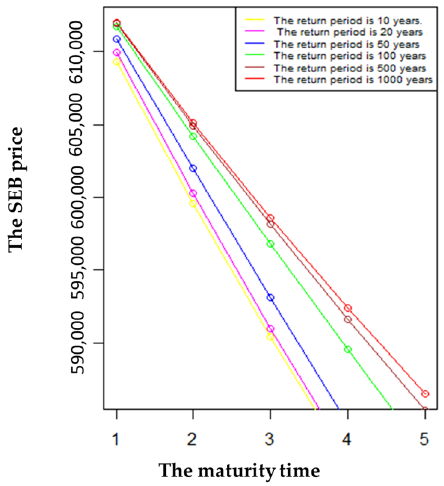
Figure 20. SEB price based on return level in cluster type II with e = 0.05, PV = IDR 1,000,000, T = 1,2,3,4,5, ReturnPeriod = 10,20,50,100,200,500,10000